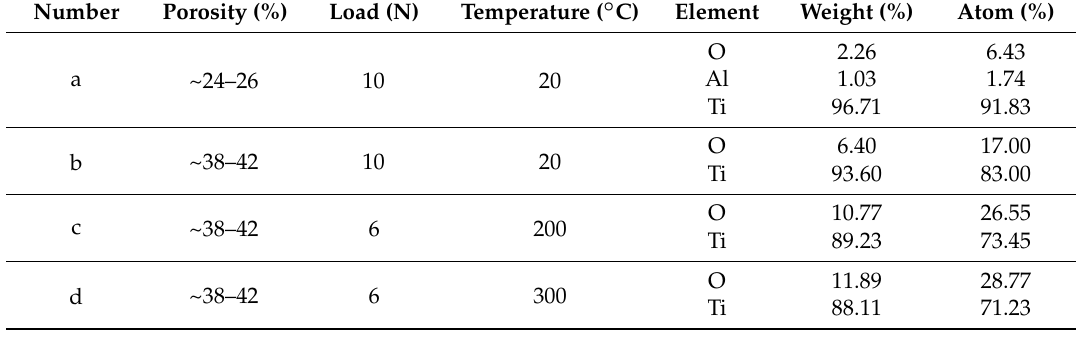
Table 6. Element composition in porous titanium samples under different conditions.